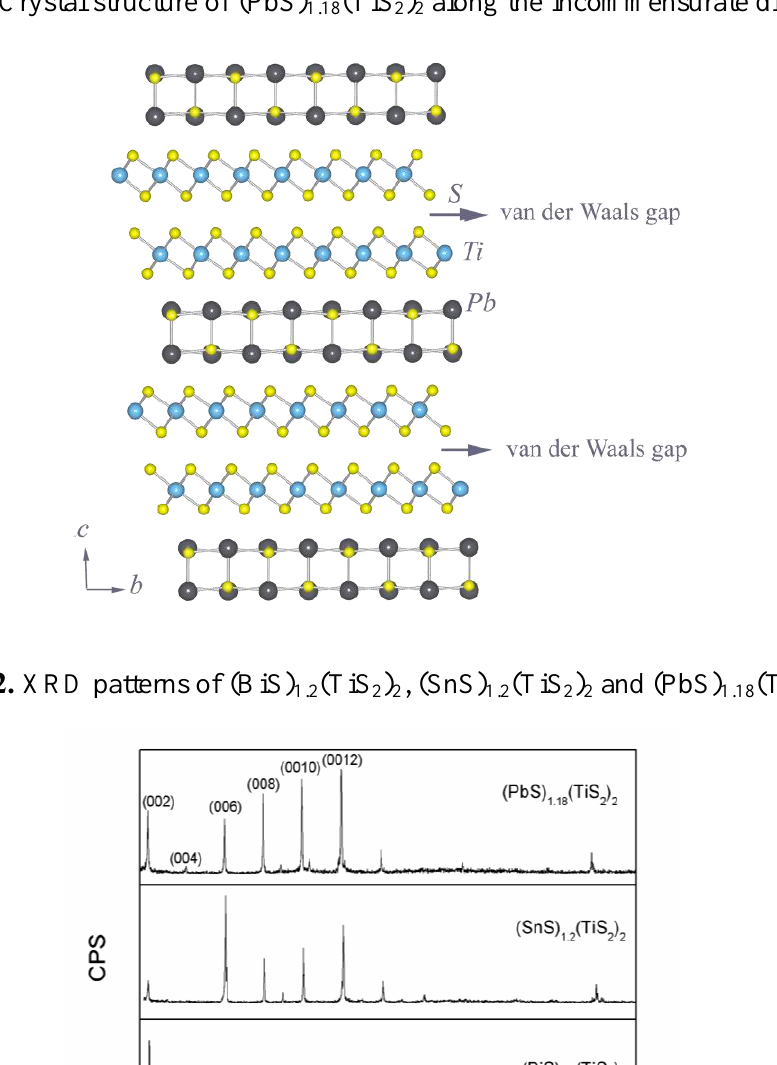
Figure 1. Crystal structure of (PbS) 1.18 (TiS 2 ) 2 along the incommensurate direction.